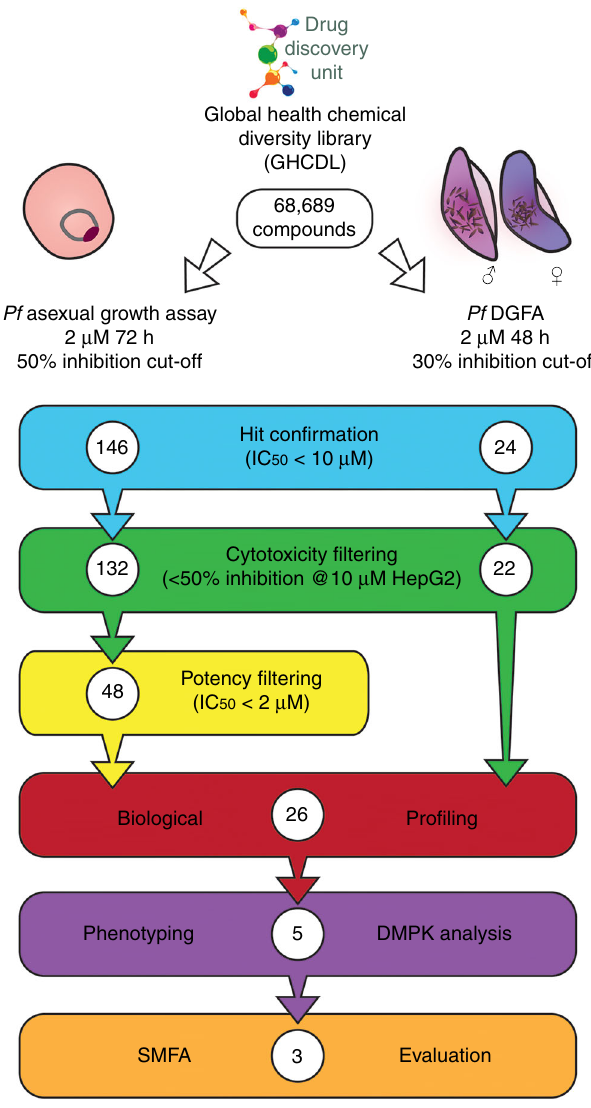
Fig. 1 Screening progression cascade. The Global Health Chemical Diversity Library (GHCDL) was screened in parallel against Plasmodium falciparum asexual stage and male and female gametocyte. Actives were recon fi rmed and cytotoxic compounds removed. Asexual hits were further fi ltered based upon potency and 26 compounds selected for further pro fi ling based upon potency and commercial availability. Five compounds with